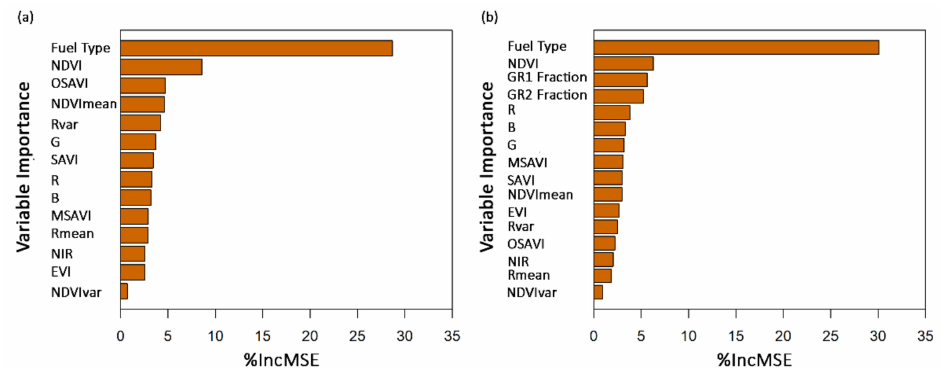
Figure 8. The variable importance for biomass models based on medium spatial resolution images and texture indices, ( a ) without and ( b ) with fractional cover as explanatory variables-. The variable importance for biomass model based on medium spatial resolution images. The X -axis indicated the percent increase in Mean Square Error (%IncMSE). BGfraction and GRfraction indicated the fractional cover of GR1 and GR2,